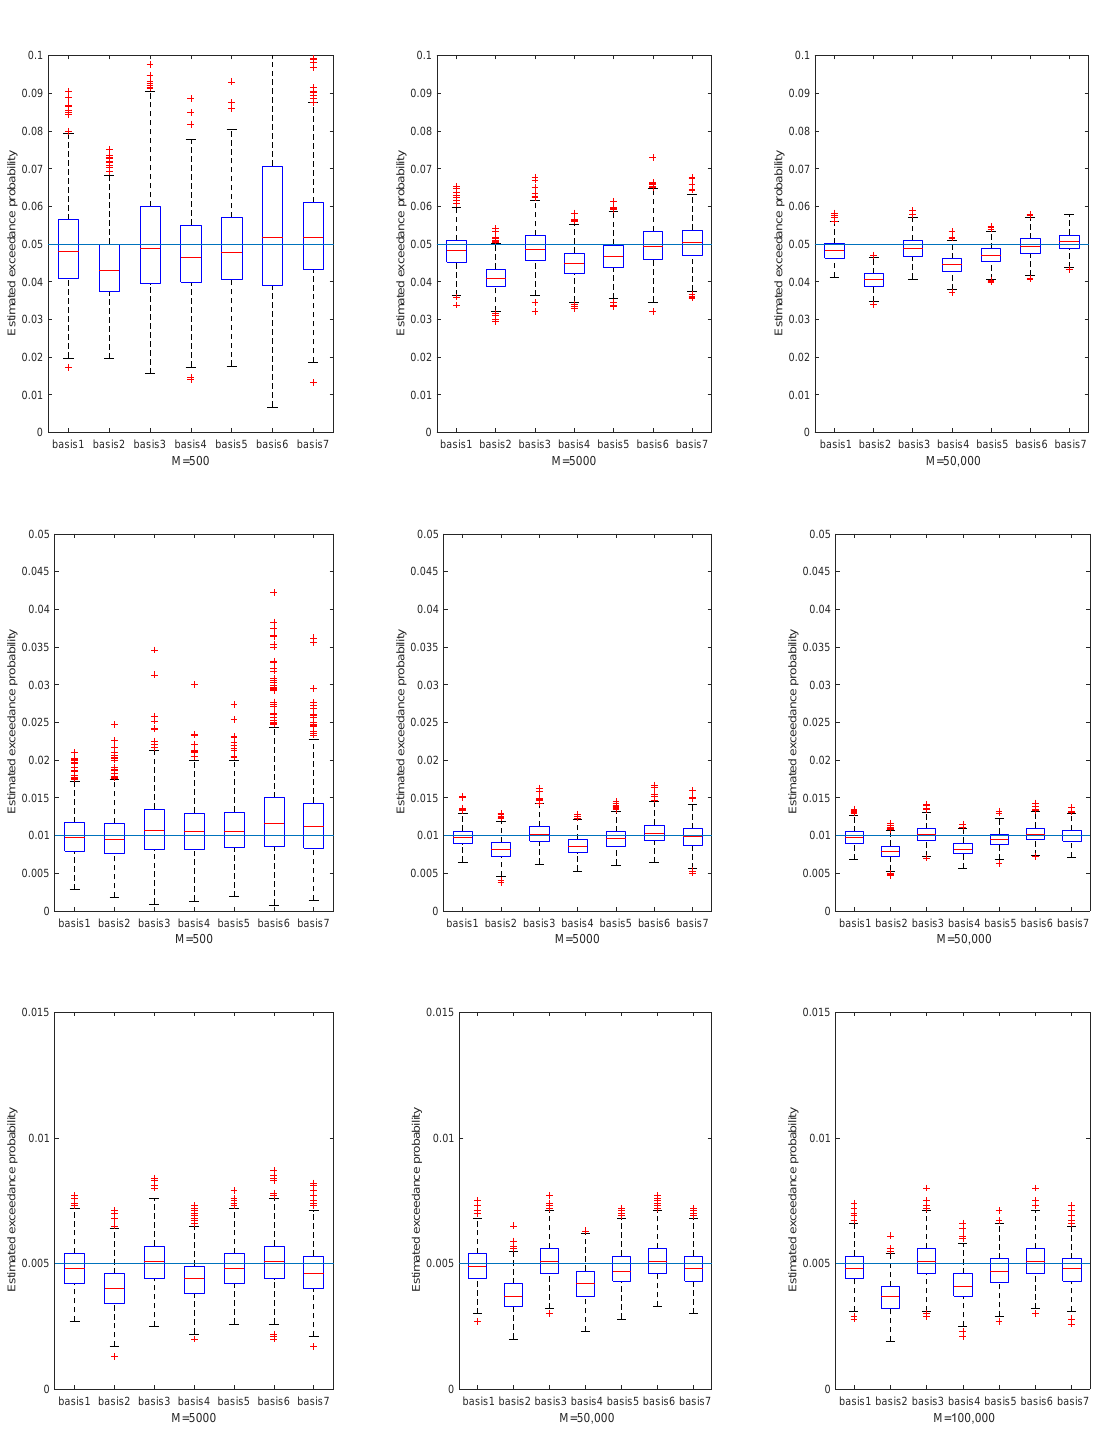
Figure 5. The estimated exceedance probability given the estimated VaR in portfolio 4. Set α = 0.95, 0.99 and 0.995. The three subfigures in the first row correspond to α = 0.95, the three subfigures in the second row correspond to α = 0.99, and the three subfigures in the third row correspond to α =